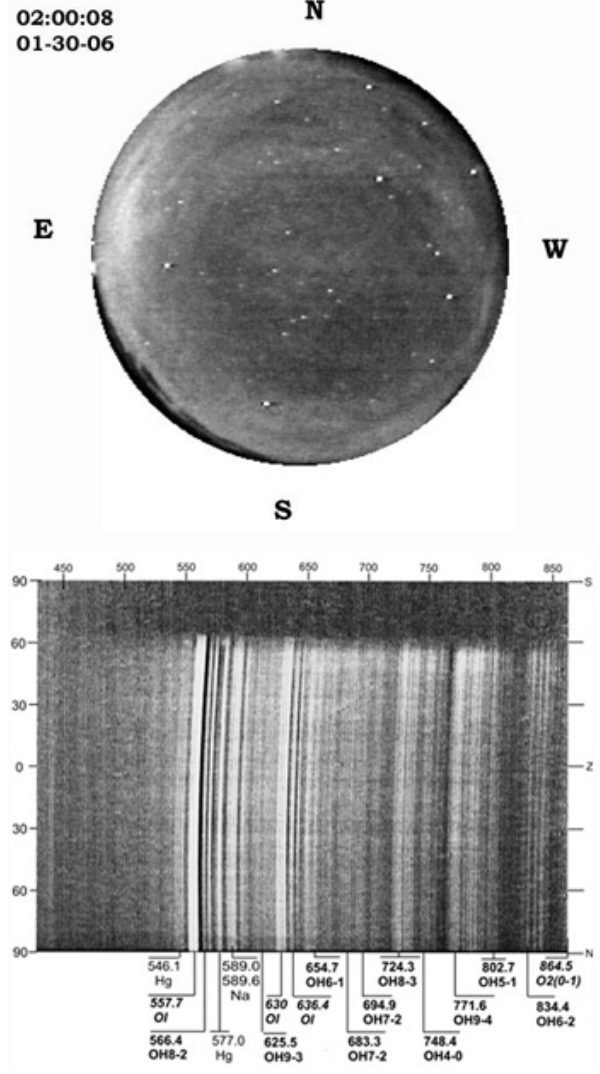
Fig. 4. Example of the nightglow spectrum registered by CCD spec- tral camera with integration time one hour (low panel) and night- glow image registered by the TV (SIT) camera in Barentsburg dur- ing time without aurora (upper